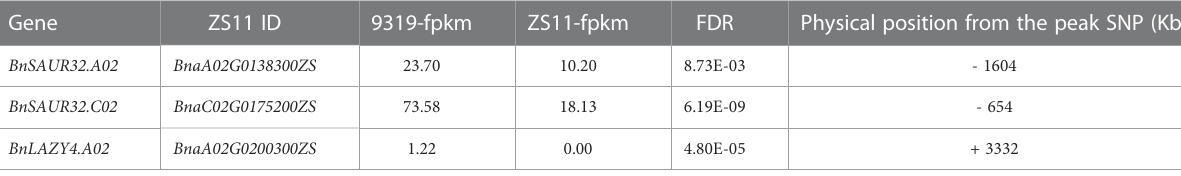
TABLE 3 Candidate genes for pod orientations prioritised by combining GWAS and RNA-seq results. Gene ZS11 ID 9319-fpkm ZS11-fpkm FDR Physical position from the peak SNP (Kb) BnSAUR32.A02 BnaA02G0138300ZS 23.70 BnSAUR32.C02